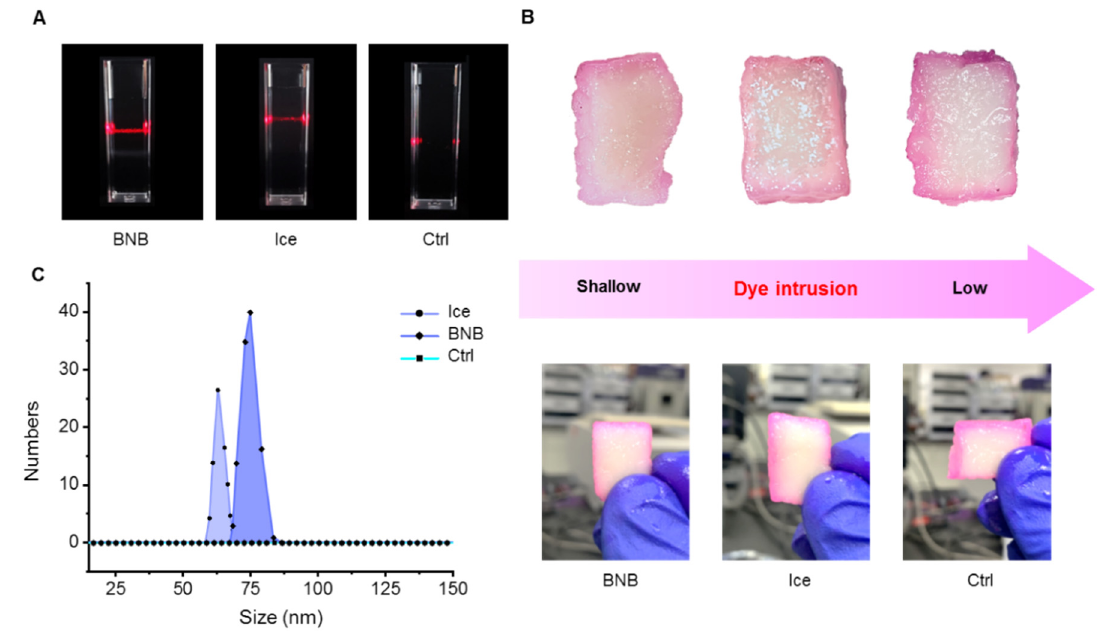
Figure 1. Characterization of freeze/thaw-induced BNBs. ( A ) Tyndall effect in different types of water; ( B ) dye intrusion to the fat cooked in different types of water; ( C ) the size distribution of nanobubble water and ice-melted water.